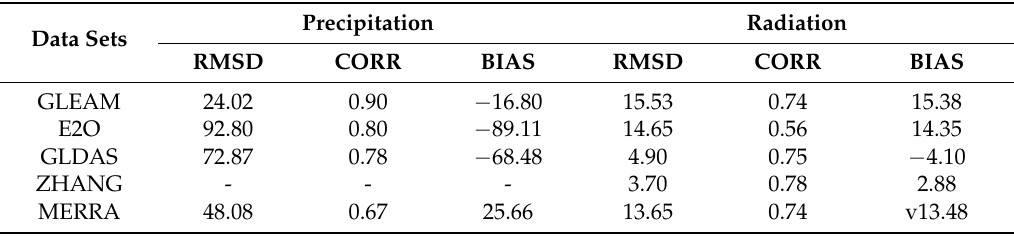
Figure 6. ( a ) The annual precipitation and ( b ) the shortwave downward radiation across the Yellow River Basin used in the GLEAM, E2O, GLDAS, and MERRA_land products. Table 4. Error metrics of precipitation and radiation data across the Yellow River Basin in the GLEAM, the E2O, the GLDAS, the ZHANG, and the MERRA_land products, referred to P_CMA and Ra_ITPCAS, respectively.